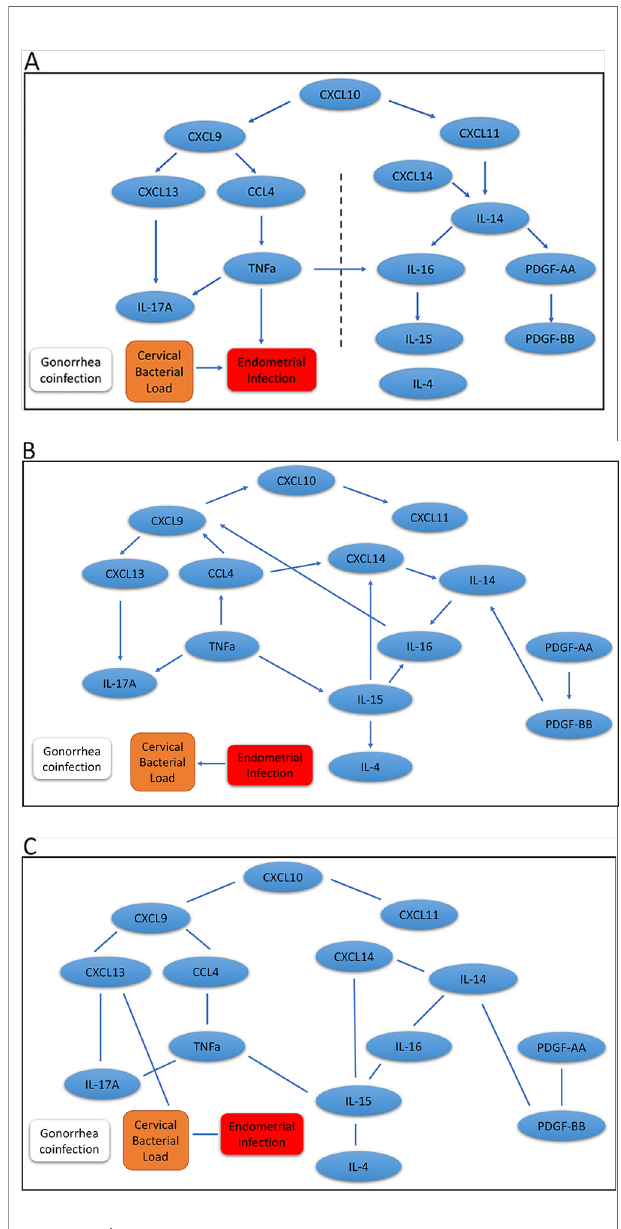
FIGURE 2 | Graphic results for causal network analysis of human Chlamydia infection dataset, a mixed type dataset consisting of continuous variables, including expression of 14 cervical cytokines and one covariate (cervical chlamydial load), and categorical variables, including the binary disease outcome (endometrial infection: Endo+ vs. Endo-) and a binary covariate (gonorrhea coinfection) by mDAG and two alternative methods, respectively. The arrows indicate direction of causality. (A) mDAG; (B) MMHC; (C) CPC- stable. The dashed line in (A) separates cytokines connected to ascension on the left, from cytokines disconnected from ascension on the